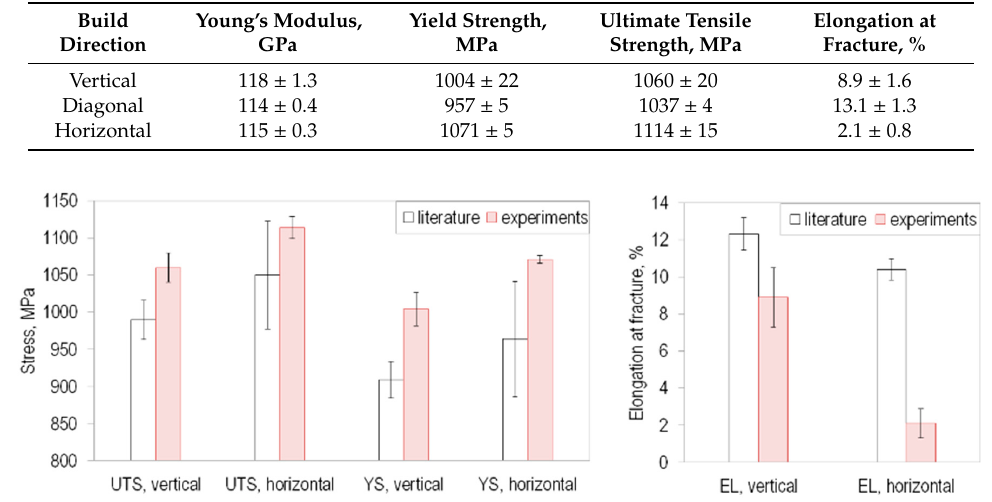
Figure 3. Engineering and true stress-strain curves from monotonic tensile test on EBM Ti-6Al-4V samples. Table 3. Monotonic tensile properties of EBM Ti-6Al-4V samples built in different orientations.